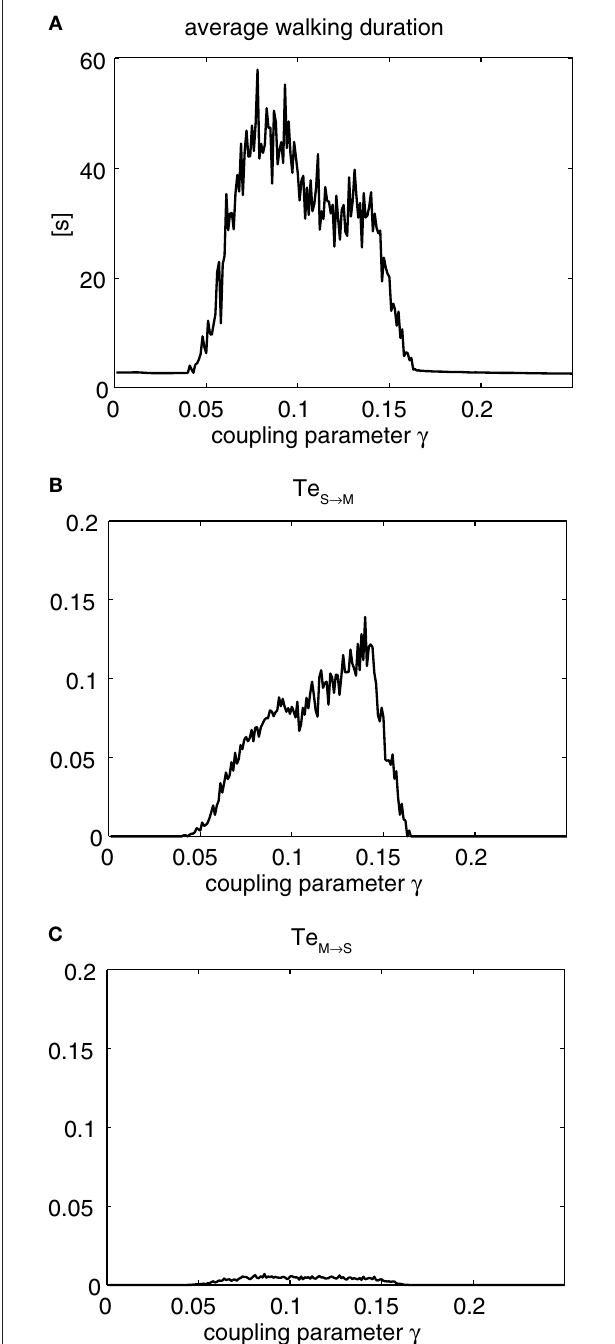
= γ = γ ∈ [0; 0.25] over 1 2